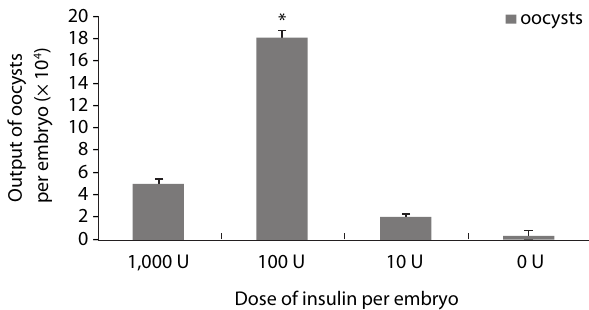
Fig. 1. – Yeilds of E. tenella in embryos with different concentrations of insulin. * p < 0.05, n =